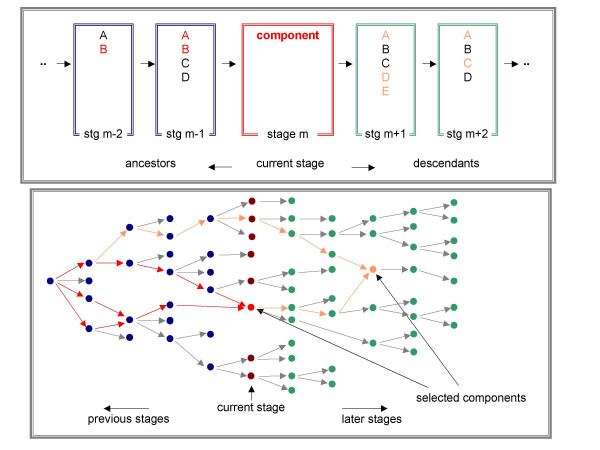
Using visualisation to trace lineage intuitively. A more intuitive visual solution to the current textual method (top) for displaying lineage across stages is shown to the right. The lineage paths trace evolution of a component from the root to another component across a number of stages.